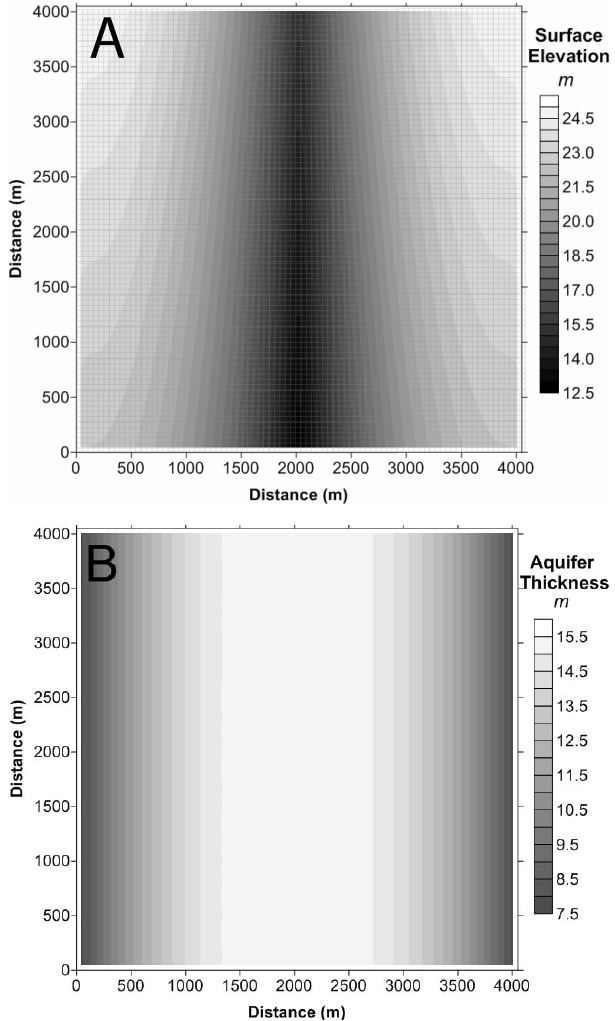
Fig. 3. Contour representation of (A) ground surface elevation and (B) aquifer thickness. Both datasets are used to create the three- dimensional subsurface finite-element mesh.